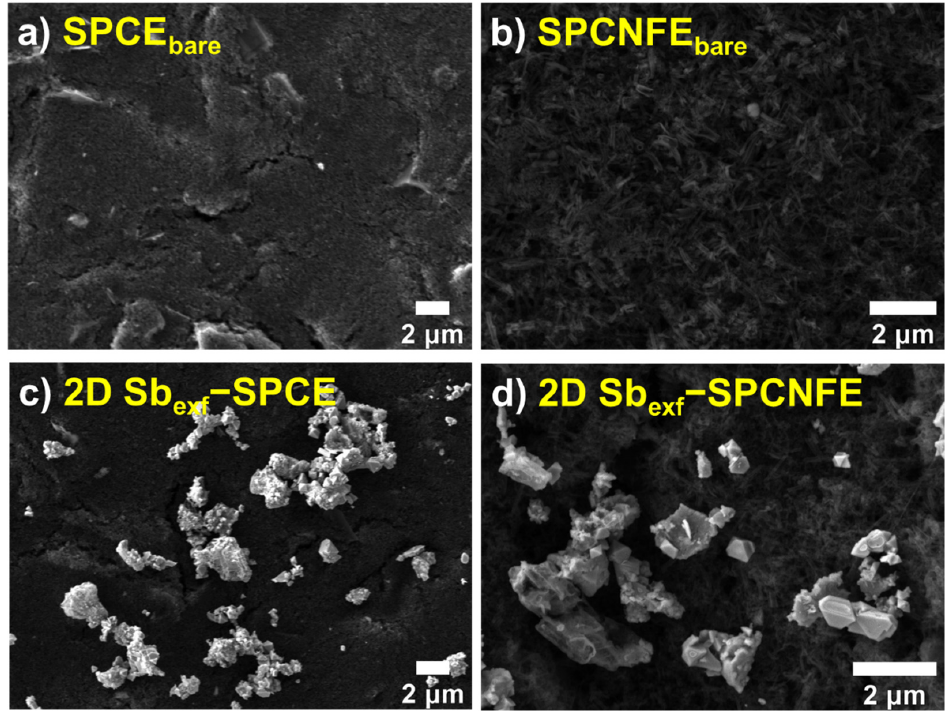
Figure 1. SEM micrographs of ( a ) SPCE bare , ( b ) SPCNFE bare , ( c ) 2D Sb exf -SPCE, and ( d ) 2D Sb exf - SPCNFE.